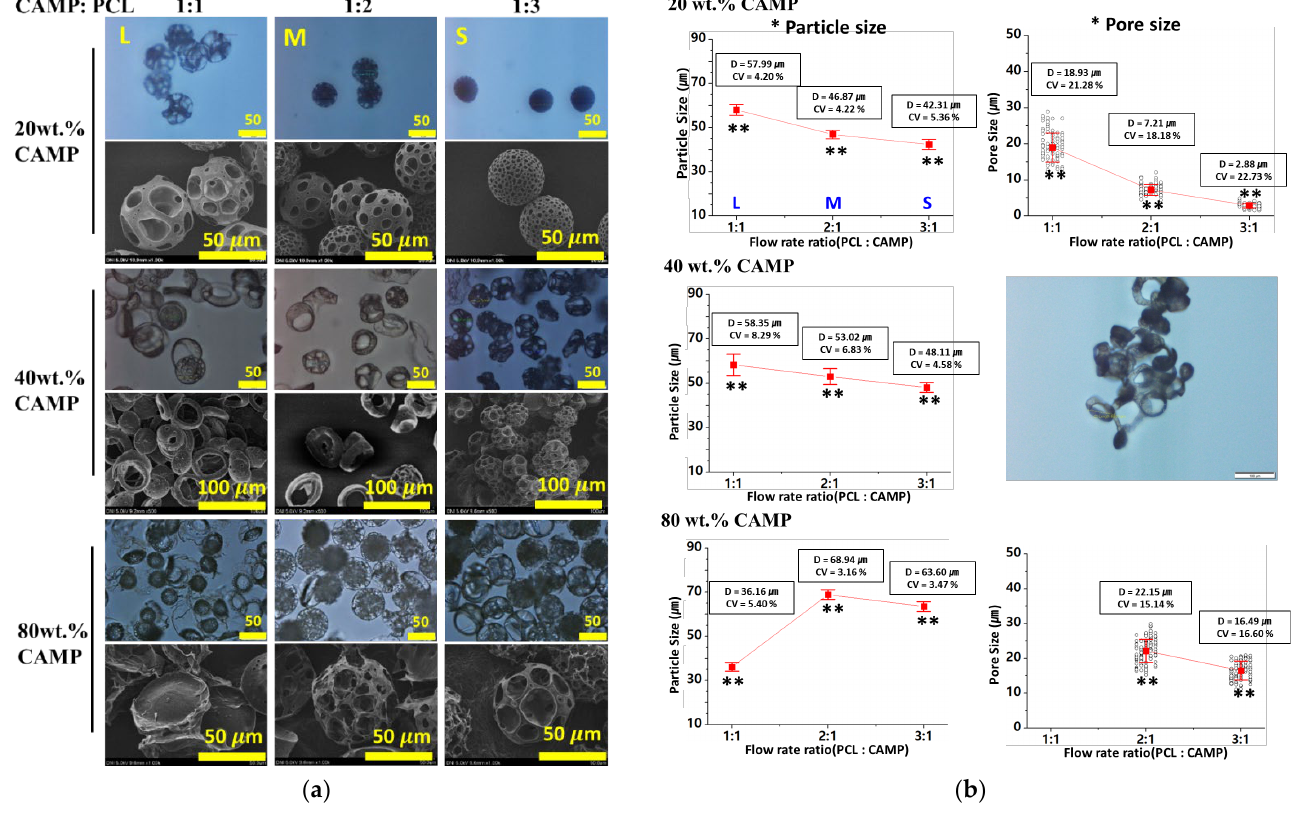
Figure 2. ( a ) Optical and SEM images of highly porous microspheres prepared by the in situ microfluidic system according to the flow rate ratio (CAMP: PCL) and the concentration of CAMP (20, 40, and 80 wt.%). As the dispersed phases, 0.5 and 0.5 mL/h for 1 (CAMP): 1 (3 wt.% PCL), 0.33 and 0.67 mL/h for 1:2, 0.25, and 0.75 mL/h for 1:3. The flow rates of the continuous phase flow (2 wt.% PVA) were 5, 10, and 20 mL/h for 20, 40, and 80 wt.% CAMP. ( b ) Porous microsphere size prepared under various conditions, such as 20, 40, and 80 wt.% CAMP concentrations in DCM and flow